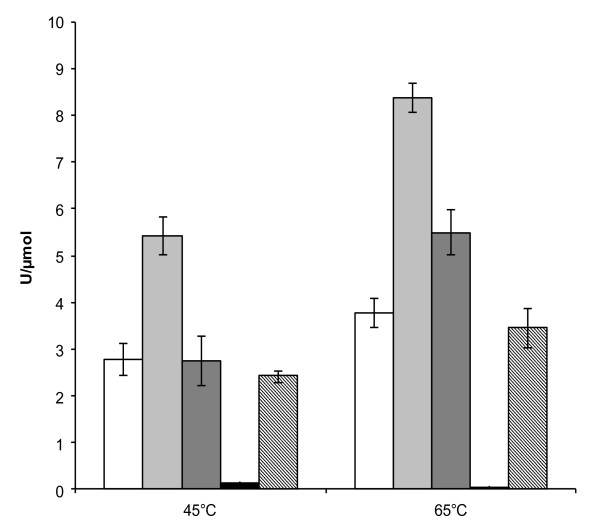
Hydrolysis of crystalline cellulose at different temperatures. Hydrolysis was performed on Avicel for 16 hours at 45°C or 65°C with: PpGH (white bars), PpCBM15:GH (light gray bars), PpCel45A (dark gray bars), PpCBM11-5 (black bars) and PpGH+PpCBM11-5 in equimolar amounts (striped bars).